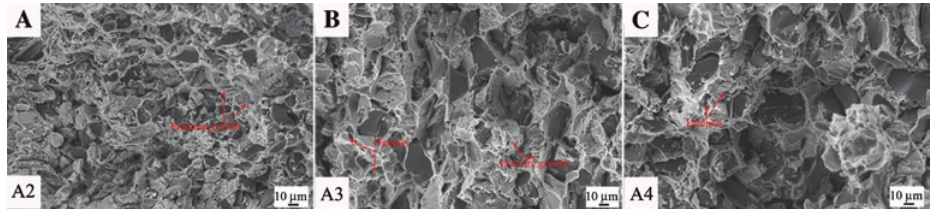
Figure 9: Fracture surfaces of the tensile samples: (A) A2, (B) A3, and (C)